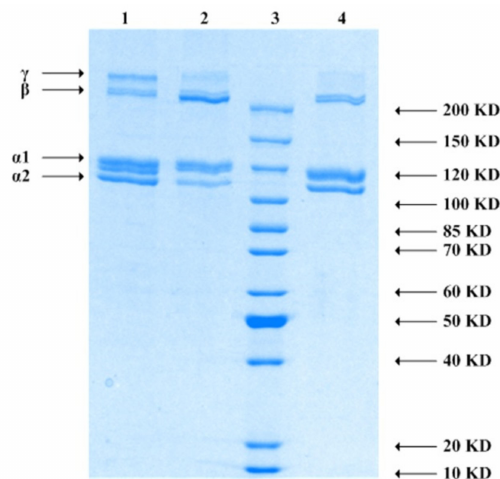
Figure 3. SDS-PAGE patterns of collagens. Lane 1: The skin of grass carp and (GCC), lane 2: The skin of crucian carp (CCC), lane 3: ladder, lane 4: The scales of grass carp (GSC). α : α chain, β : β chain, α 1: α 1 chain, α 2: α 2